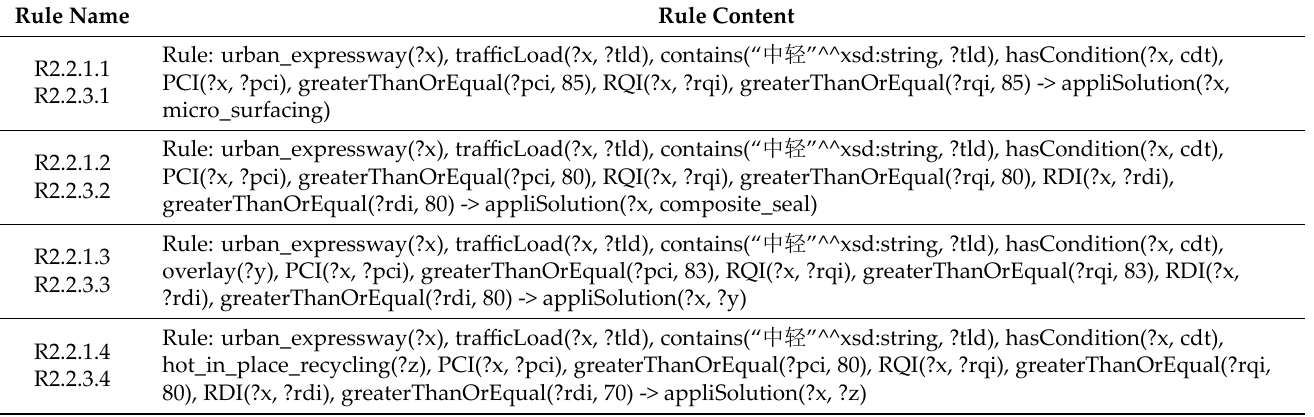
Table A1. Renewal rules for expressways with skid resistance loss/pavement wear and moder‑ ate/mild traffic load.